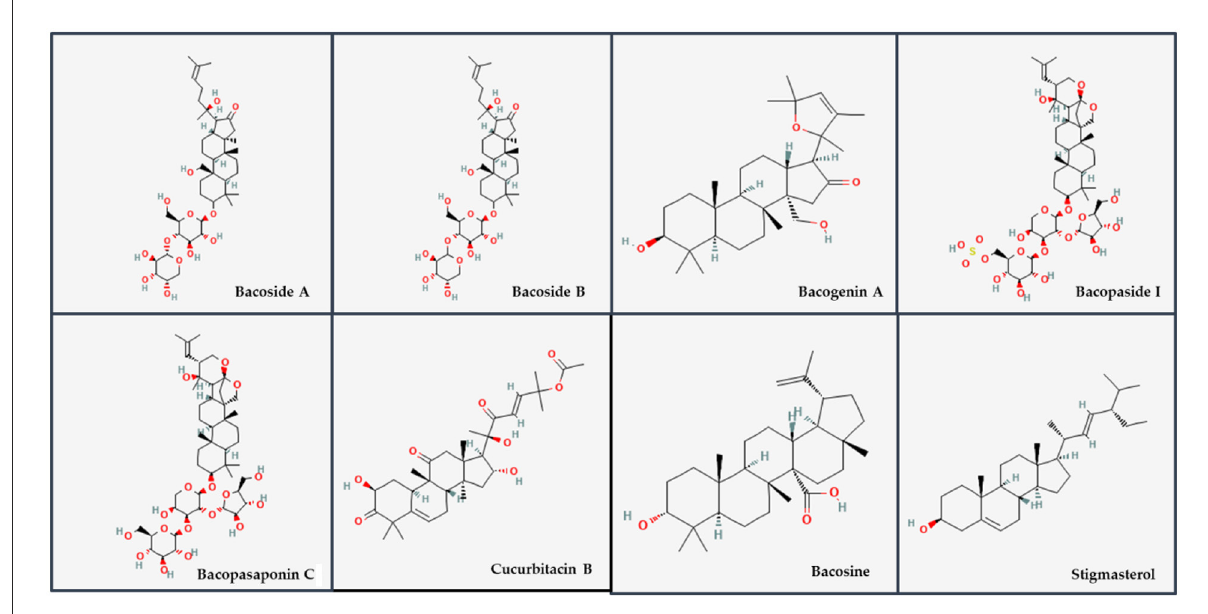
FIGURE2 Representative structures of major phytoconstituents present in extracts of Bacopa monnieri. Structures were downloaded from PubChem (https://pubchem.ncbi.nlm.nih.gov) with their corresponding PubChem CIDs, Bacoside A (92043183), Bacoside B (121596009), Bacogenin A (101600046), Bacopaside I (21599442), Bacopasaponin C (21599443), Cucurbitacin B (5281316), Bacosine (71312547), and Stigmasterol